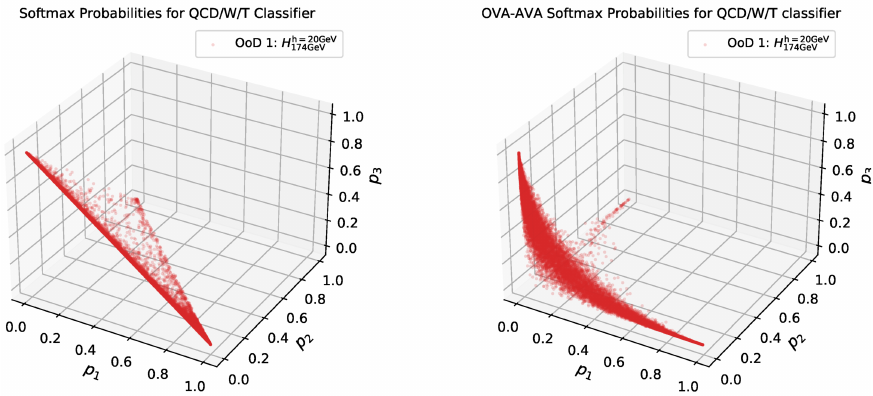
Figure 4 . Softmax probabilities of out-of-distribution examples within the standalone AVA classifier ( left ) and the combined OVA-AVA scenario ( right